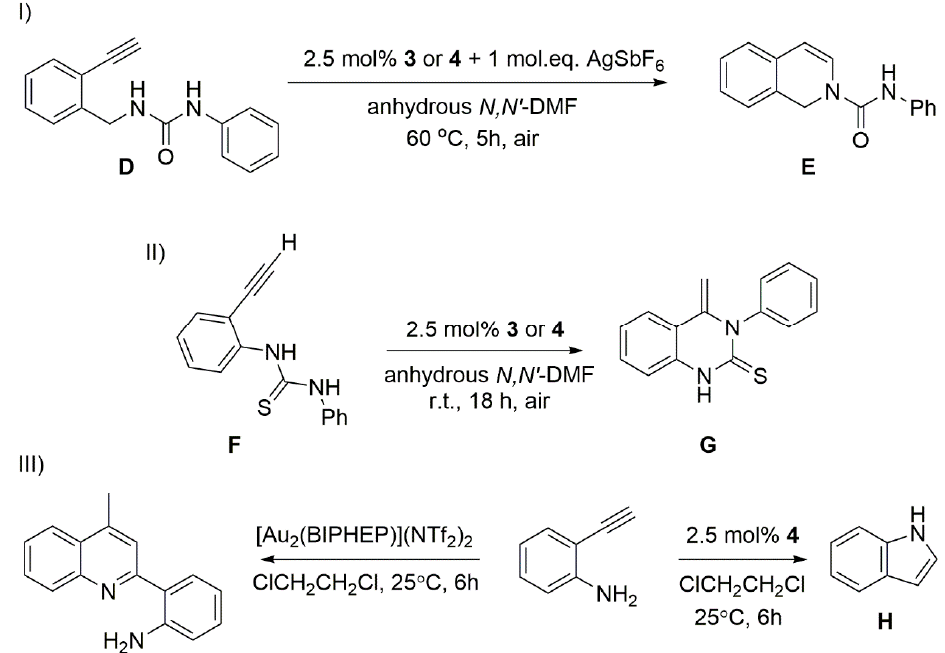
Figure 5. Comparison of regioselectivity to indole B under various dilution conditions, obtained with dinuclear catalyst 4 in the presence of one equiv. of AgSbF 6 vs. mononuclear benchmark AuCl(P t Bu 3 ) with one equiv. AgSbF 6